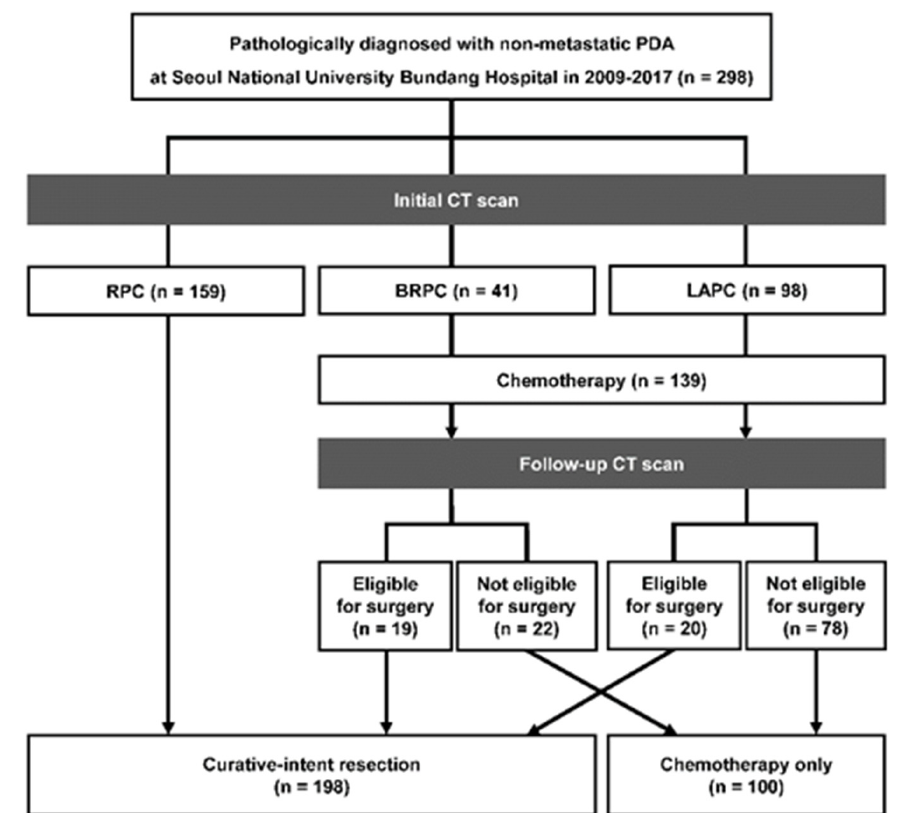
Figure 1. Flowchart of the study population. Table 1. Baseline characteristics of the study population ( n =